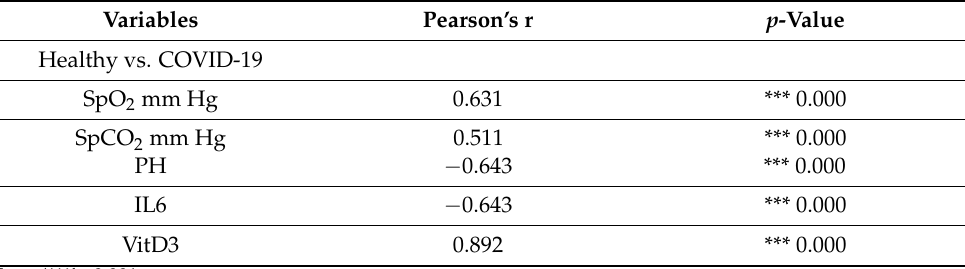
Table 5. Analysis of the correlation between variables and healthy vs. sick